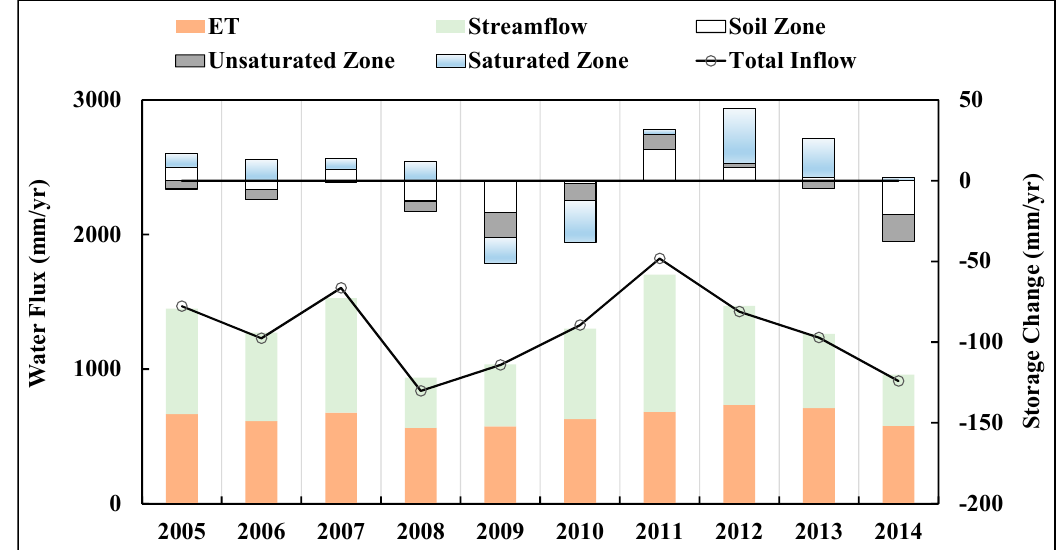
Figure 14. Annual variability in the total inflow, ET, streamflow, and storage changes in the surface and soil zone, unsaturated zone, saturated zone and whole system.